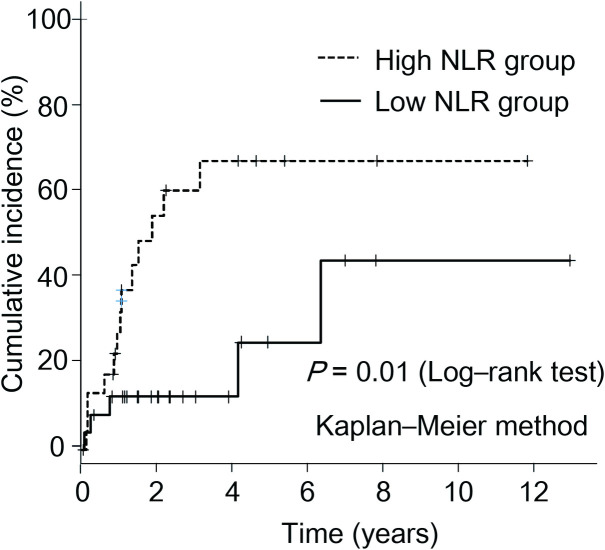
Comparison of cumulative incidence of pouchitis between the high and low NLR groups.The incidence of pouchitis was significantly lower in the low NLR group than in the high NLR group (P = 0.01, log-rank test).